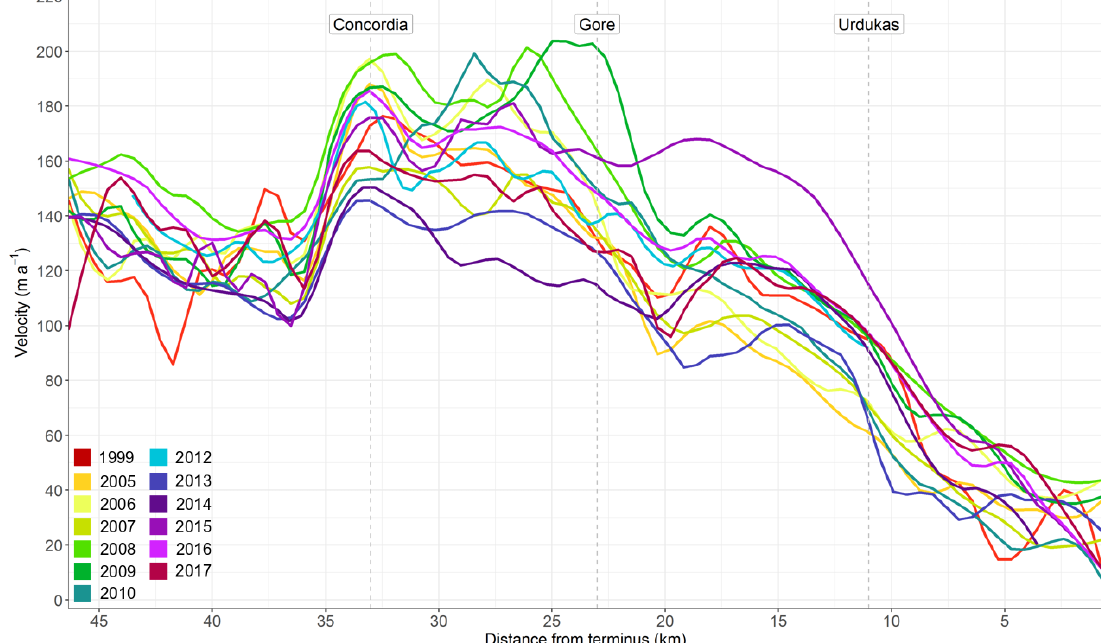
Figure 3. Averaged summer surface velocities (m a − 1 ) along the glacier’s